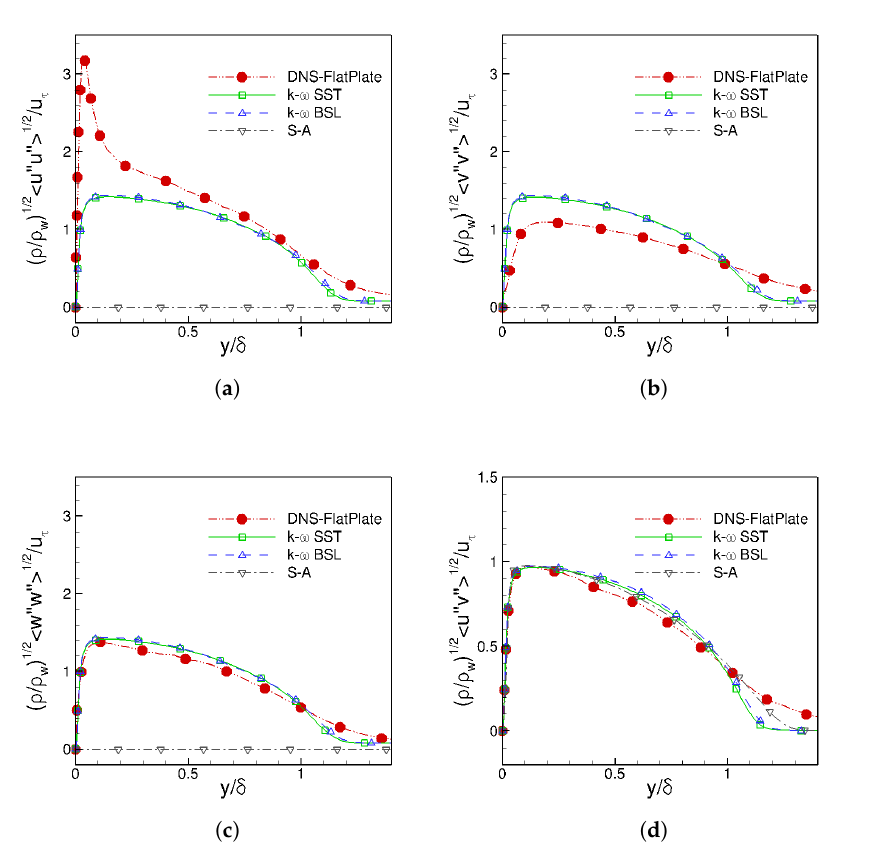
Figure 6. Comparison of Reynolds stresses at Re τ ≈ 500 between RANS and DNS. ( a ) Reynolds streamwise stress (cid:103) u (cid:48)(cid:48) u (cid:48)(cid:48) ; ( b ) Reynolds wall-normal stress (cid:103) v (cid:48)(cid:48) v (cid:48)(cid:48) ; ( c ) Reynolds spanwise stress (cid:103) w (cid:48)(cid:48) w (cid:48)(cid:48) ; ( d ) Reynolds shear stress (cid:103) u (cid:48)(cid:48) v (cid:48)(cid:48)